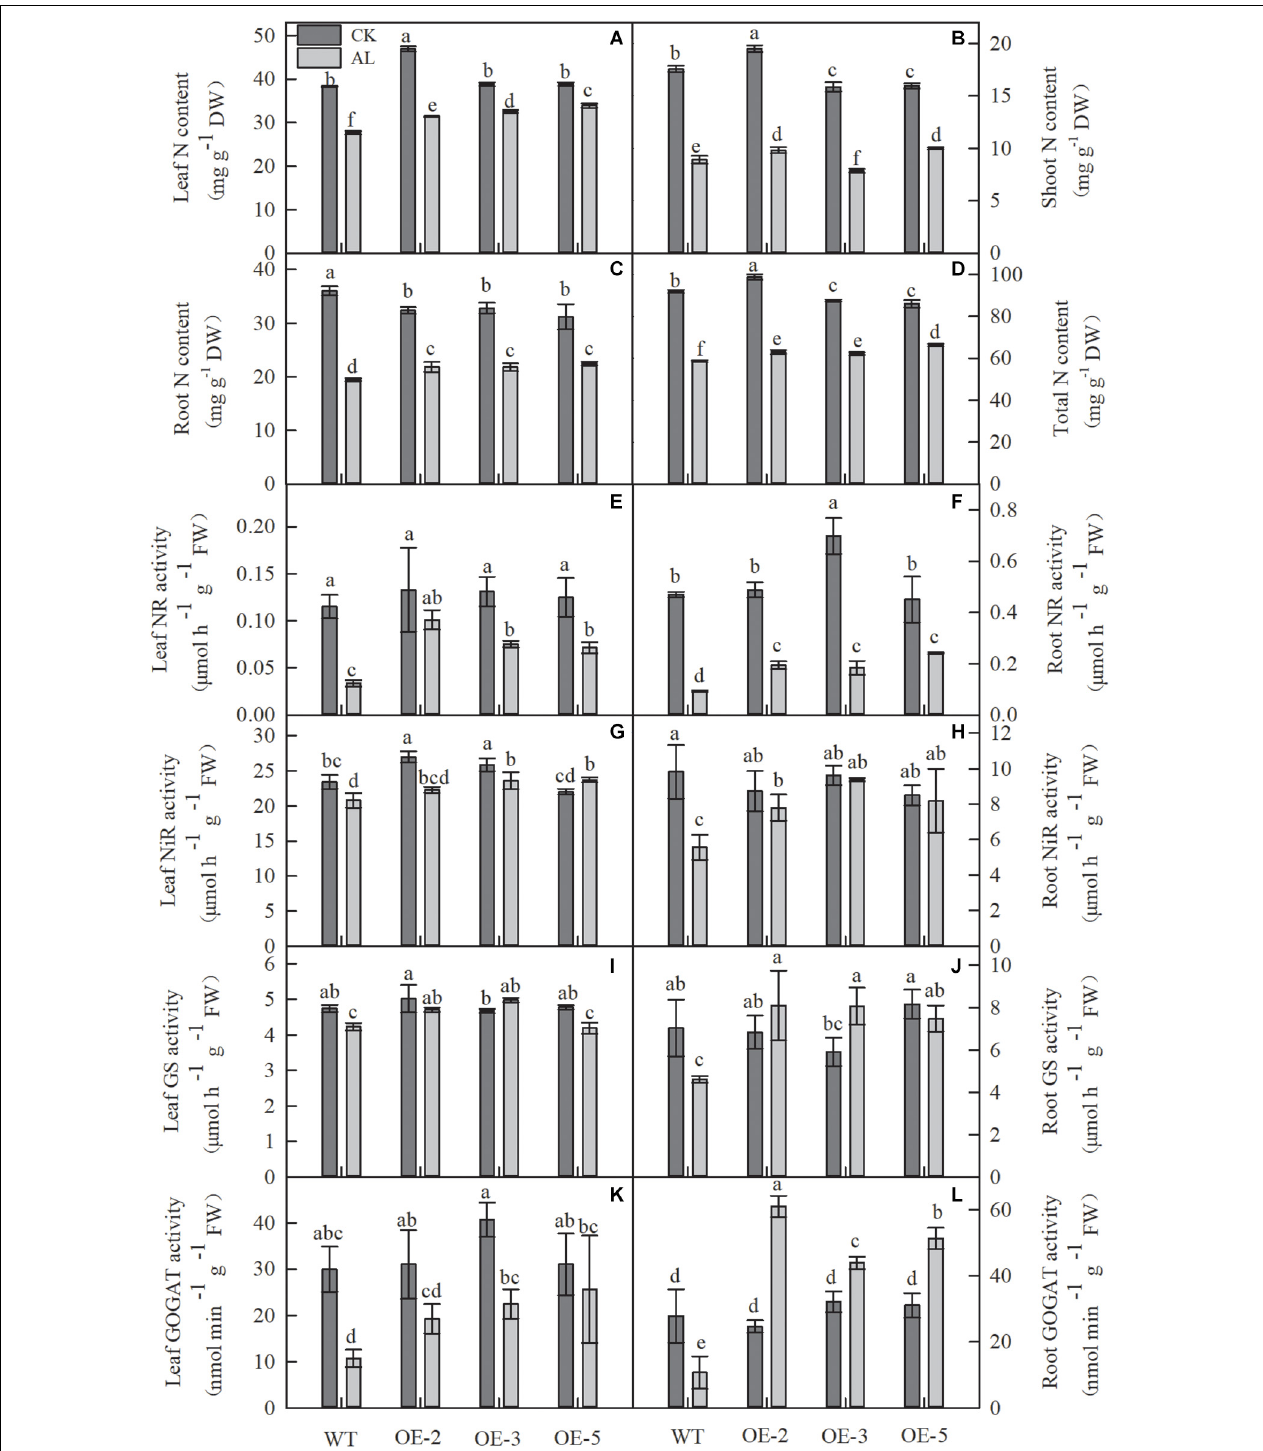
FIGURE 7 | Alkaline stress caused less damage to the nitrogen content and the activity of enzymes involved in N metabolism in MdTyDc OE apples than in WT apples. (A) Leaf N content, (B) shoot N content, (C) root N content, and (D) total N content, (E) the activity of leaf NR, (F) root NR, (G) leaf NiR, (H) root NiR, (I) leaf GS, (J) root GS, (K) leaf GOGAT, and (L) root GOGAT. The data are presented as means ± SD ( n = 3). Significant differences between WT and MdTyDc overexpression lines are indicated by different lowercase letters based on Tukey’s multi-range test ( P < 0.05). WT, wild type. OE-2, MdTyDc overexpression line 2. OE-3, MdTyDc overexpression line 3. OE-5, MdTyDc overexpression line 5.